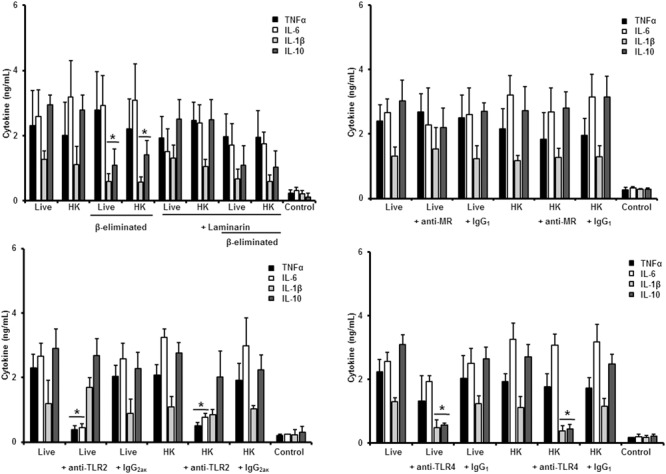
Cytokine production by human PBMCs stimulated with S. brasiliensis germlings. As Figure 6, but germlings cells were used. ∗P < 0.05, when compared with untreated cells.